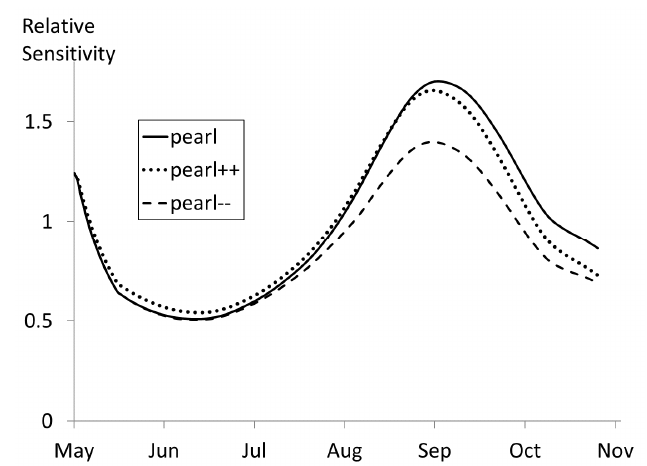
Figure 14. Results of the global sensitivity analysis when increasing ( ++ ) or decreasing ( −− ) the initial biomass concentration of fathead minnow for pearl dace.